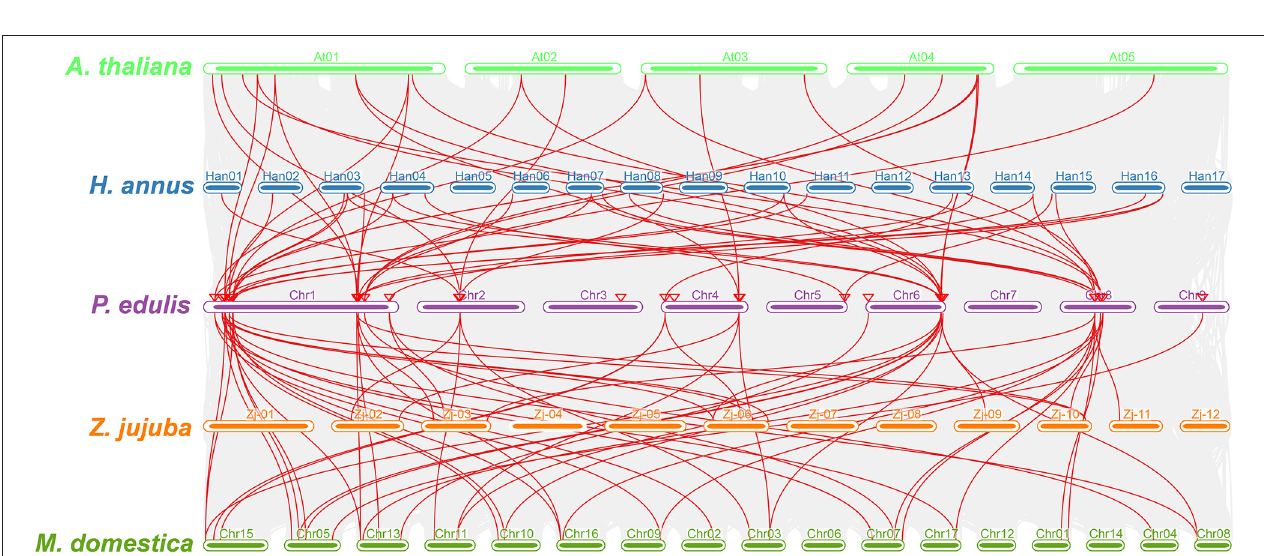
FIGURE 3 | Chromosomes of P. edulis are represented with Chr1-Chr9, A. thaliana with At01-At05, M. domestica with Chr01-Chr17, and Z. jujuba with Zj-01 to Zj-12. The background gray lines show all the syntenic blocks in different genomes, blue lines represent the syntenic relationship among P. edulis and M. domestica CER genes, red lines represent the syntenic relationship among P. edulis and A. thaliana genes, and green lines represent the syntenic relationship among P. edulis and Z. jujuba genes.